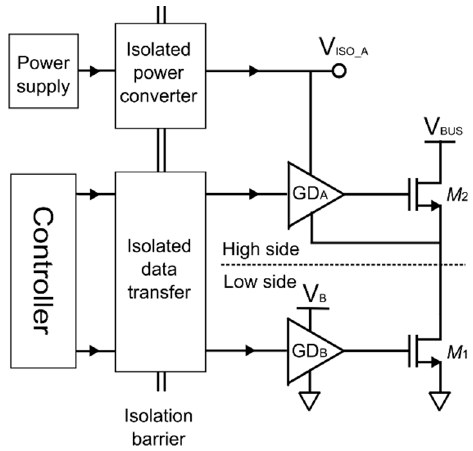
Figure 3. Simplified scheme of an isolated gate driver application for half-bridge configuration.